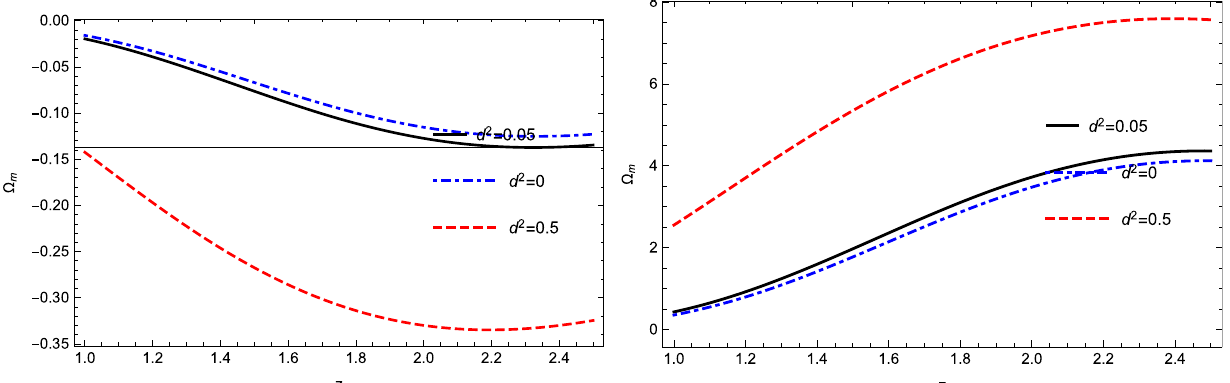
Fig. 16 Plot of (cid:9) m verses z for u = 1 and u = 2 . 002 for Bianchi type-V